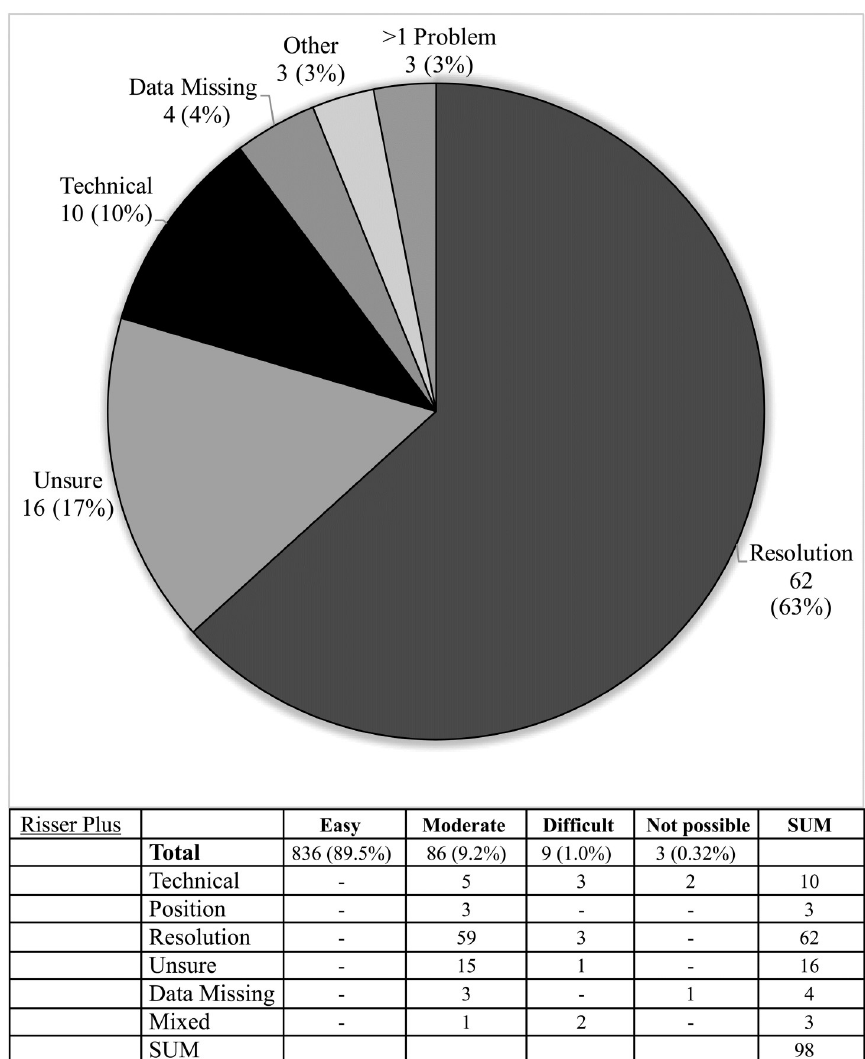
resolution to assess image easily; positioning—landmark not visible, or not clearly visible due to limb rotation or shadowing; and if rater was ‘unsure’ due to problems with method